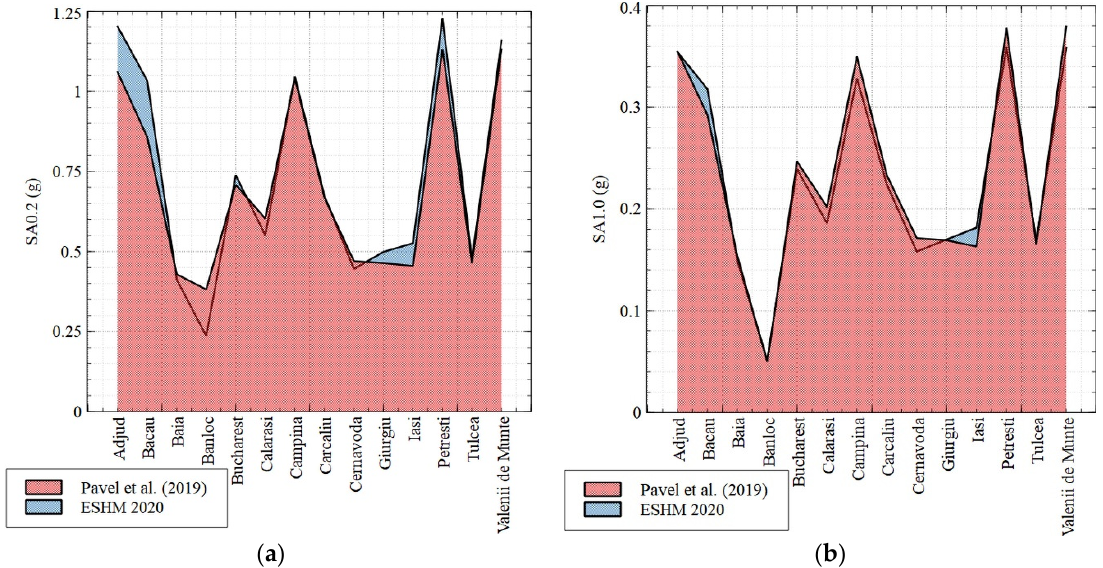
Figure 3. ( a ) A comparison between the spectral accelerations that had a mean return period of 475 years for rock conditions for T = 0.2 s obtained from the seismic hazard model of Pavel et al. [27] and from the ESHM 2020 model [26]; ( b ) a comparison between the spectral accelerations for rock conditions for T = 1.0 s obtained from the seismic hazard model of Pavel et al. [27] and from